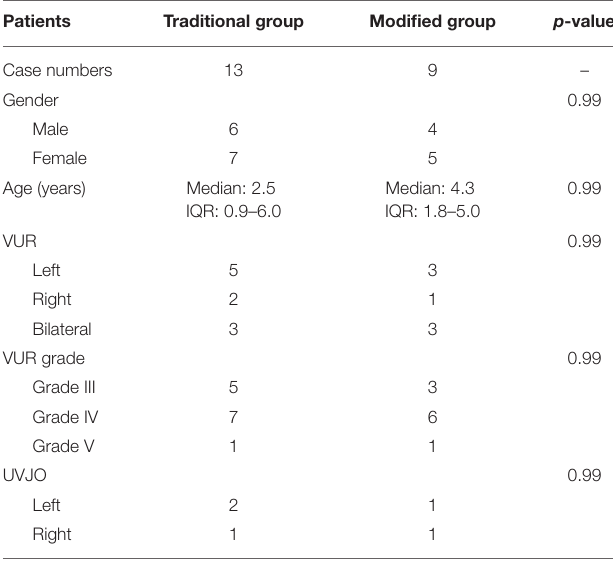
TABLE 1 | Clinical characteristics of the patients in the two